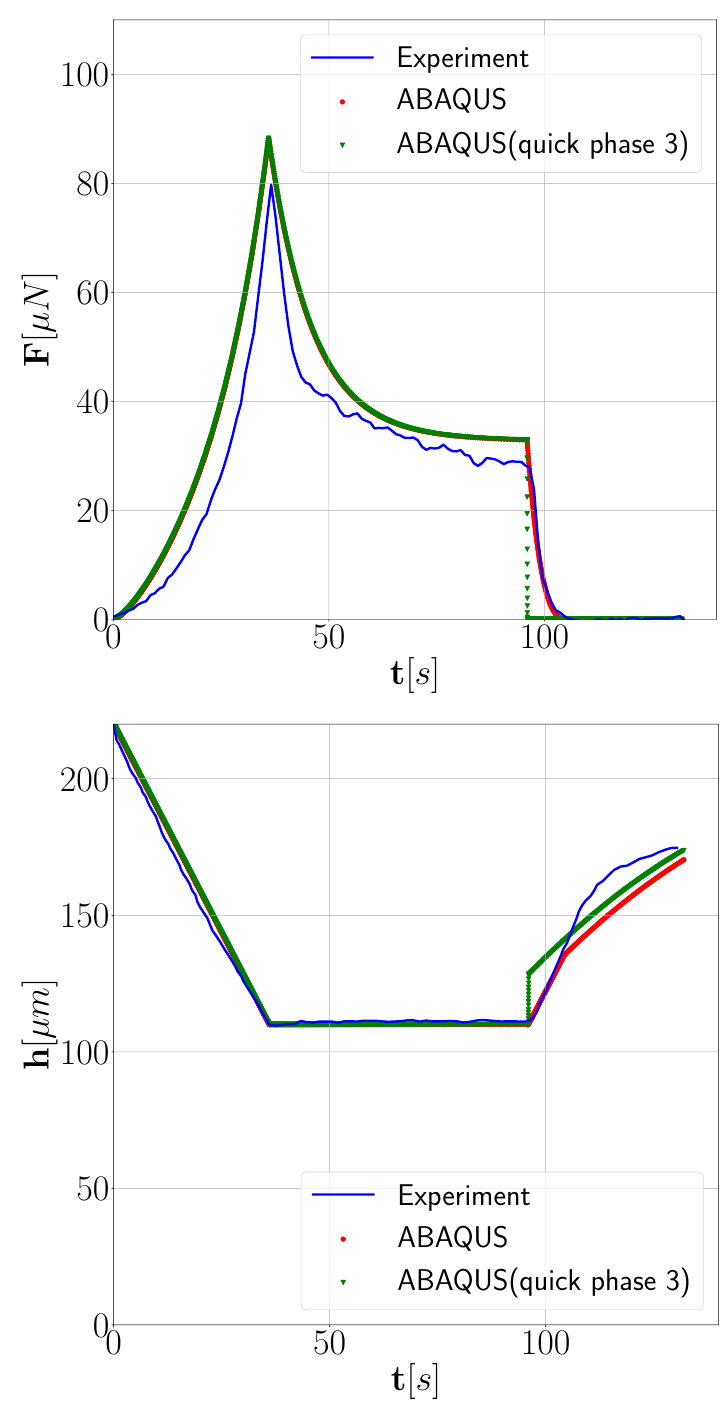
Figure 4. The reaction force acting on the upper plate ( top ) and the spheroid height ( bottom ). Two scenarios of the release phase and experimental